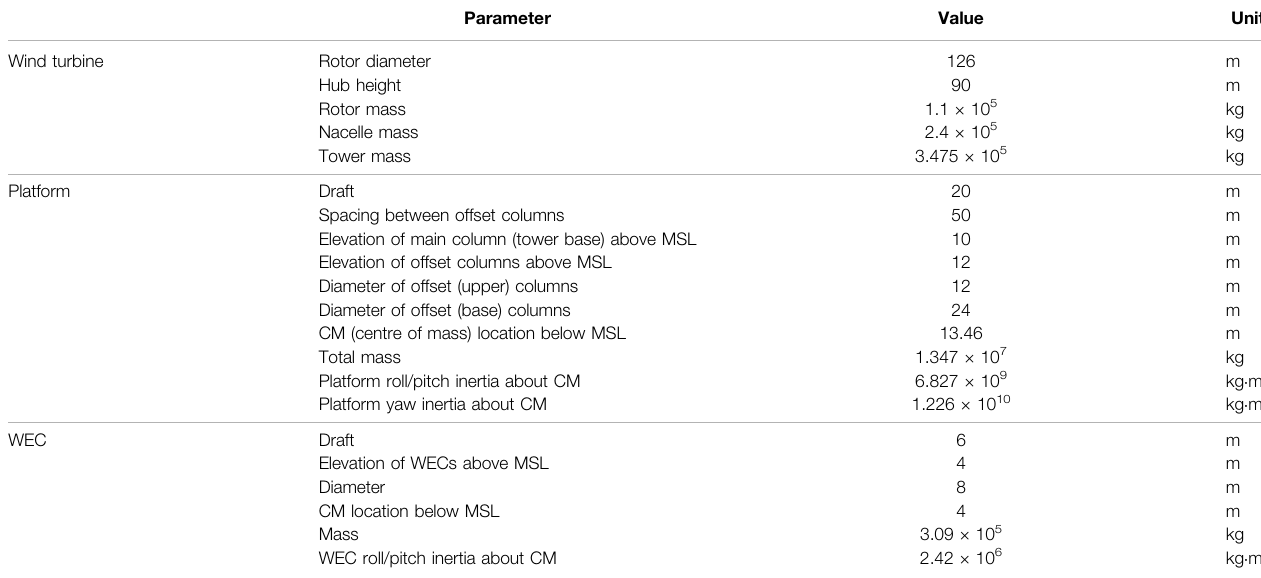
TABLE 1 | Main parameters of the hybrid system (Robertson et al., 2014) (Jonkman et al.,